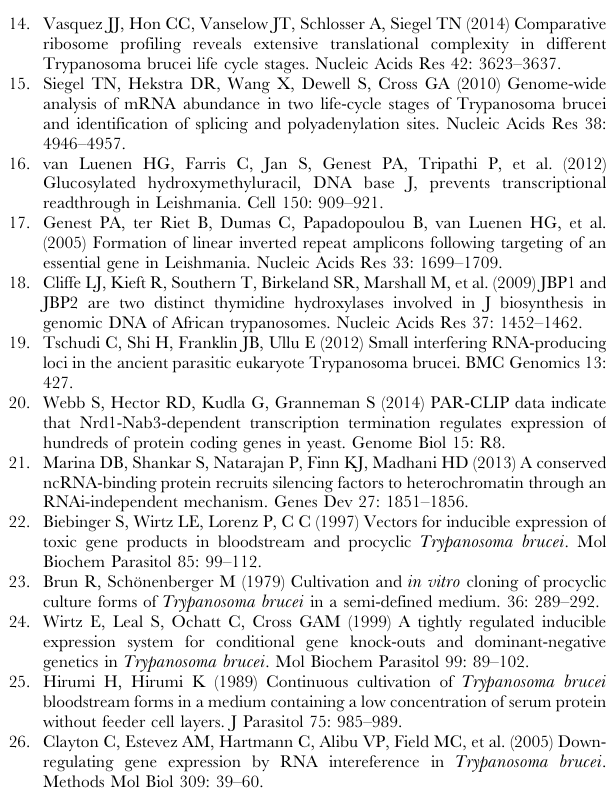
Figure S1 Alignment of RBP33 from T. brucei , T. cruzi and Leishmania major . Figure S2 Assesment of anti-RBP33 antiserum specific- ity and RBP33 abundance. (A) A single immunoreactive band is visible in total cell extracts of bloodstream and procyclic trypanosomes in western blot assays. (B) RBP33 specific staining is no longer detected when the protein is ablated by RNAi in immunofluorescence analysis. (C) Quantitation of RBP33 protein levels in procyclic trypanosomes. The abundance of RBP33 present in different amounts of trypanosome cells (left) was compared to known amounts of recombinant His 6 -CBP-RBP33 [11] (right) in western blot assays. Figure S3 Examples of Artemis plots of RNA-seq data. (A) Regions corresponding to genes FTZC (Tb927.10.8590), RBP33 (Tb927.8.990) and Tb927.7.6010 are shown. (B) Tran- scripts derived from the SSR located in between genes Tb927.10.2390 and Tb927.10.2400 increase in abundance upon RBP33 depletion. Probes used for Northern hybridizations are indicated. Probe A is identical to that used in [19]. The annotated splicing acceptor site for Tb927.10.2390 is indicated with a filled circle, and the most proximal and most distal annotated polyadenylation sites are represented with empty circles. Figure S4 RBP33 depletion has no effect on the levels of PT-X and FTZC mRNAs or FTZC protein. (A) Total RNA was obtained from trypanosomes grown in the presence or absence of tetracycline for 48 h, transferred to Nylon membranes